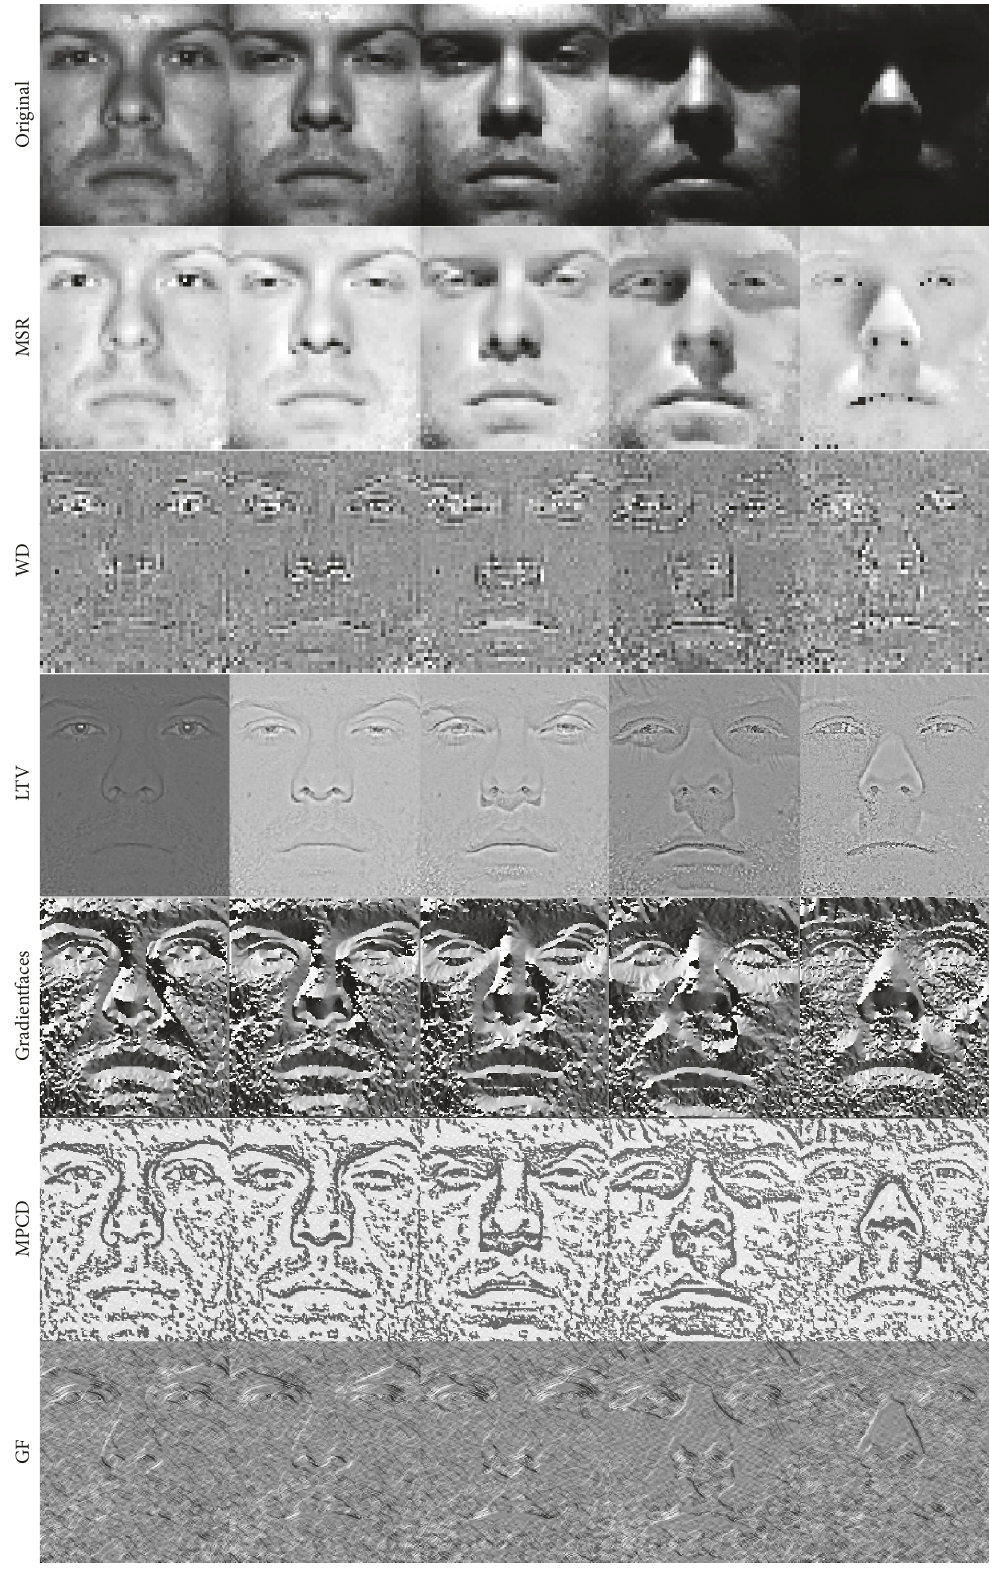
Figure 3: Examples of the different illumination